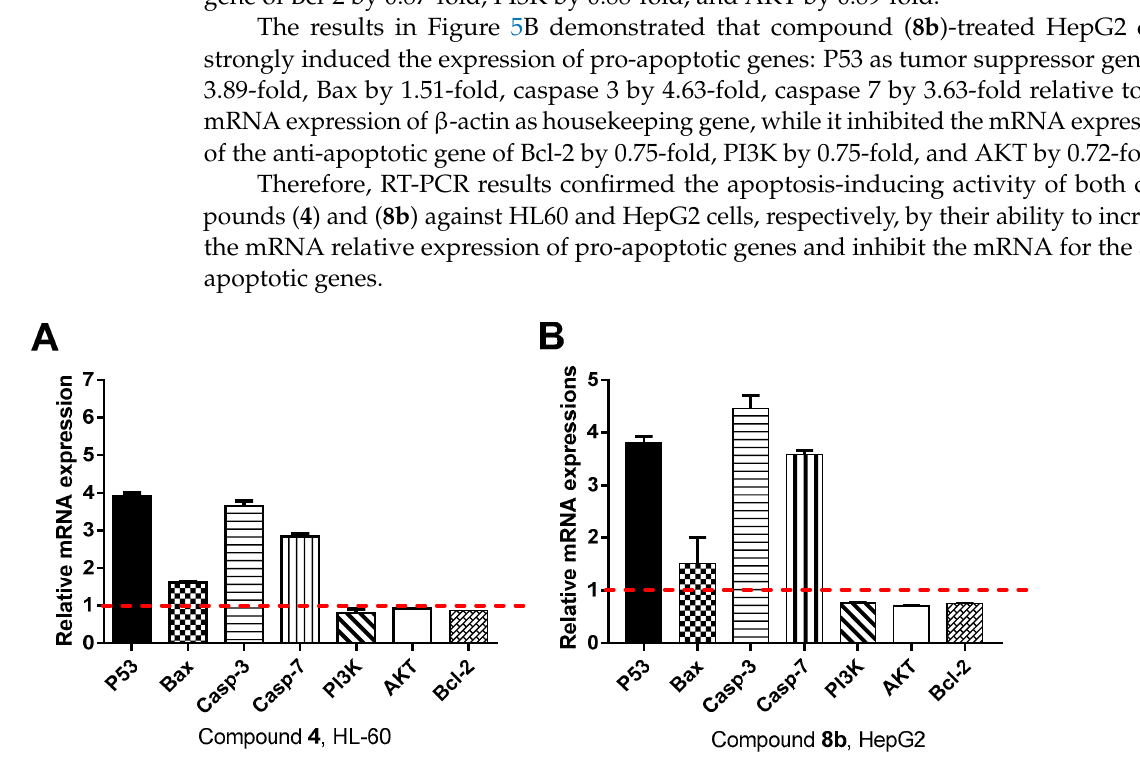
Figure 5. RT-PCR for the relative mRNA expression of treated HL60 treated with compound ( 4 ) (IC 50 = 8.09 µ M, 48 h, A ) and HepG2 cells treated with compound ( 8b ) (IC 50 = 13.14 µ M, 48 h, B ) versus β -actin as a housekeeping gene (fold change of the untreated control = 1). The data are expressed as the mean ± SEM of three independent experiments.